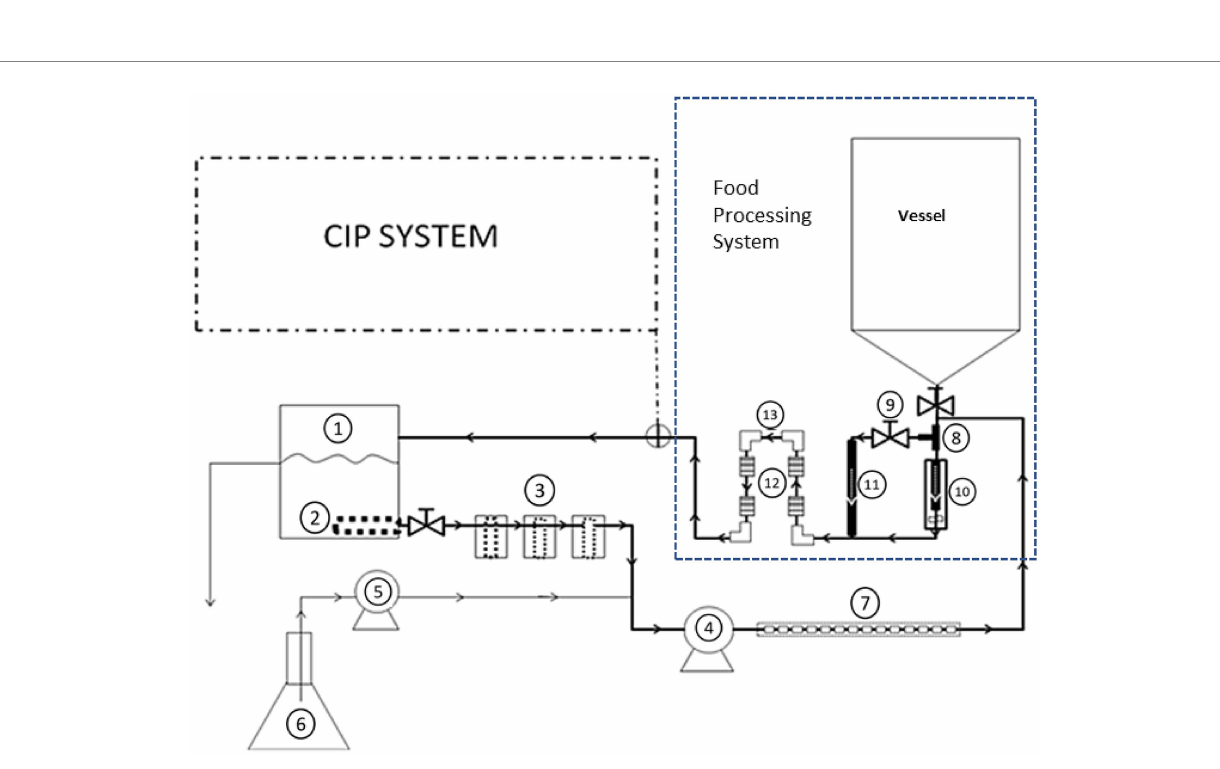
FIGURE 2 Representation of experimental set-up that includes the fouling system used to contaminate the pilot-scale processing equipment and to develop dairy biofilm on stainless steel surfaces. The fouling equipment consisted of the following parts, as numbered in the figure: (1) 19-L high density polyethylene container, (2) internal filter with 4.8 mm perforations, (3) three external filters on the line with mesh size of 20, 40, and 40, (4) peristaltic pump for circulation, (5) peristaltic pump for feeding line, (6) 5-L feeding flask, and (7) small stainless-steel tubes inserted into neoprene tubing. Components of the processing equipment included: stainless steel T-shaped pipe (8), by-pass valve (9), filler (10), by-pass line (11), four of rough surface pipe segments (12), and four smooth surface 90 ° -elbows